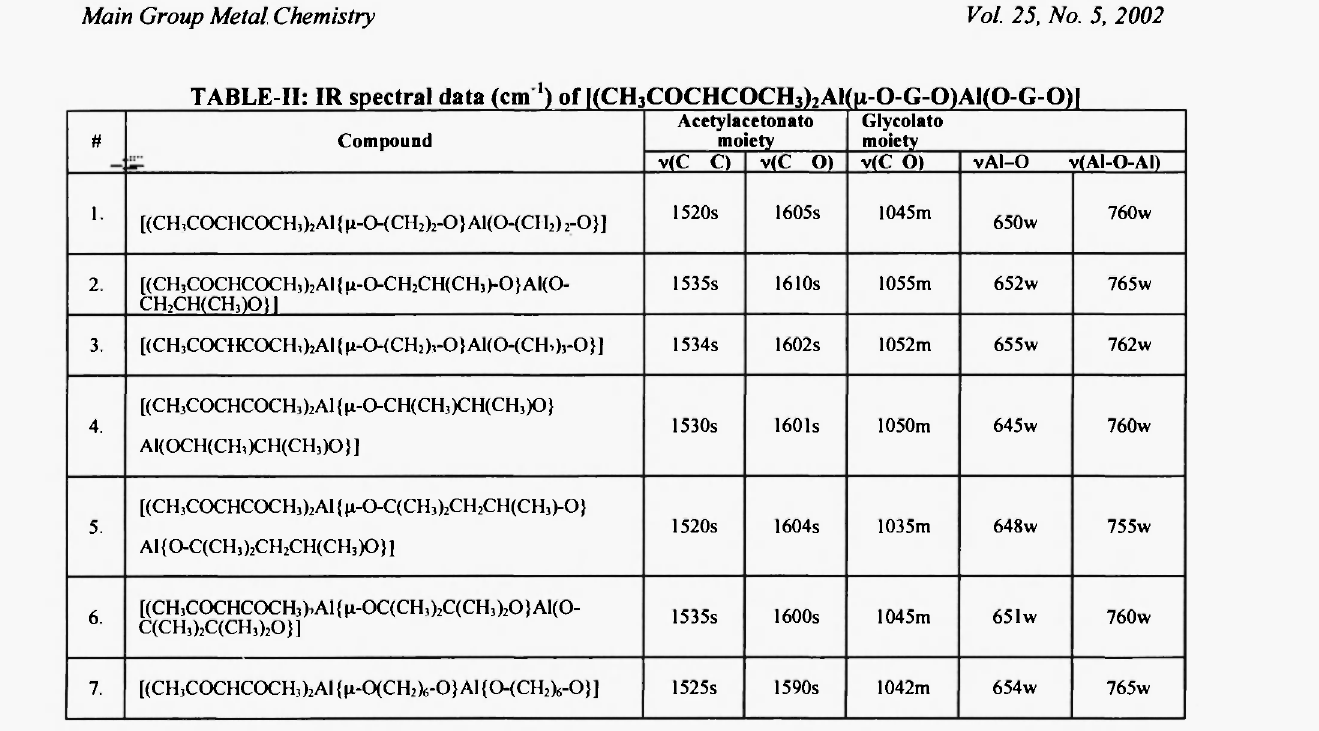
TABLE-II: IR spectral data (cm 1 ) of |(CH3C0CHC0CH 3